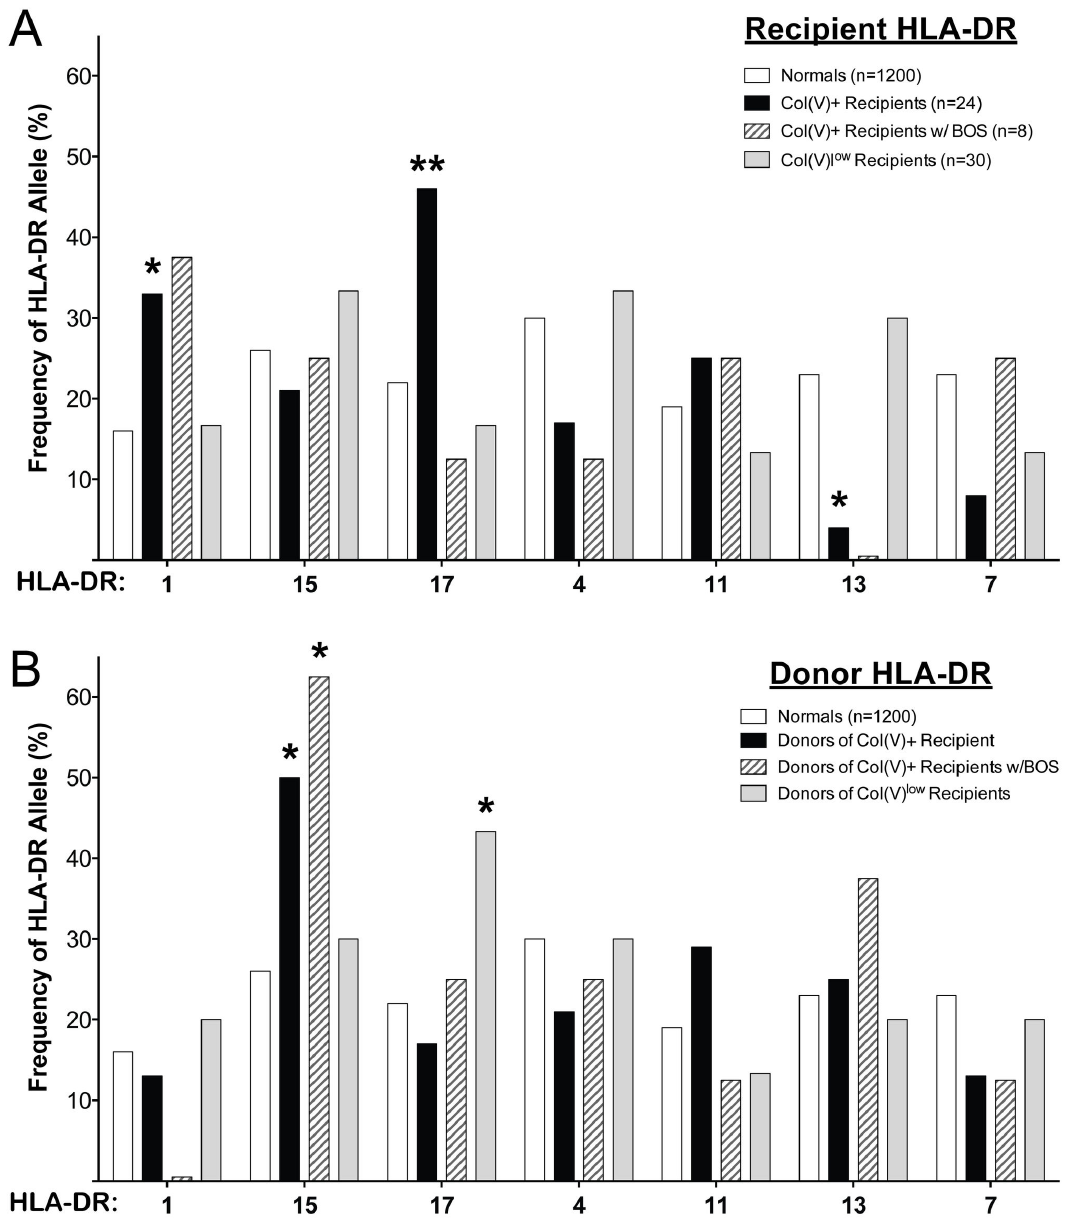
Figure 2. HLA-DR frequencies in col(V) reactive lung transplant recipients after transplantation. HLA-DR frequencies in very high col(V) reactive (TV-DTH net foot pad swelling > 25 x 10 -4 inches) lung transplant recipients (A, black bars) or their donors (B, black bars) were compared to the HLA-DR frequency of controls (1200 subjects, open bars) and non-col(V) reactive or col(V) low (≤ 25 x 10 -4 inches) lung transplant recipients (A, grey bars) or their donors (B, grey bars). HLA-DR frequencies of very high col(V) reactive recipients (and their donors) who later developed BOS 2 or 3 (hatched bars) were also compared to HLA-DR frequency of controls. There were no significant differences in the frequencies of any HLA-DR alleles between normal control subjects from the University of Wisconsin (n=1200) and lung transplant recipients/donors (n= 281 recipients) or patients screened using the TV-DTH assay (n=54), data not shown. The frequency of HLA-DR1 (33%) and –DR17 (46%) was significantly higher in transplant recipients with very high col(V) responses (>25 x10 -4 inches, A) than in normal controls (16% and 22%, respectively). HLA-DR13 was significantly less represented in col(V) responsive recipients compared to normal controls (4% vs 23% in controls). The frequency of HLA-DR15 was significantly higher in the donors of subjects who developed a high response to col(V) (50%) as well as in the donors of subjects with BOS 2/3 incidence (63%) compared to the frequency in the normal controls (26%). The frequency of HLA- DR17 was significantly higher in the donors of patients that did not have very high col(V) responses. *=p< 0.05, **= p<0.01. doi: 10.1371/journal.pone.0079601.g002 PLOS ONE |